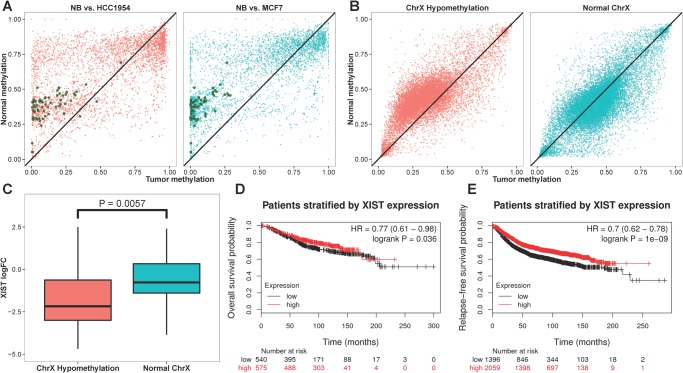
Aberrant promoter hypomethylation of genes located on the X chromosome in breast cancer cells.(A) Scatter plots of DNA methylation levels of NB (x-axis) and MCF7 and HCC1954 (y-axis; red and blue colors respectively) at promoter regions (TSS ± 1 Kb). The promoter regions that exhibited differential hypomethylation and associated with significant elevated downstream transcript expression (FDR ≤ 0.05) were colored in green. (B) Paired tumor-normal methylation assays of the TCGA BRCA dataset showed two populations of breast cancer patients where one group (colored in red) displayed promoter hypomethylation in the paired tumor samples as compared to the paired normal samples. (C) The group of BRCA patients that showed promoter hypomethylation had significantly reduced expression level of XIST in the corresponding paired tumor samples (t-test, p-value < 0.01). The (D) overall survival and (E) relapse-free survival analysis showed breast cancer patients with lower XIST expression had lower survival probabilities.